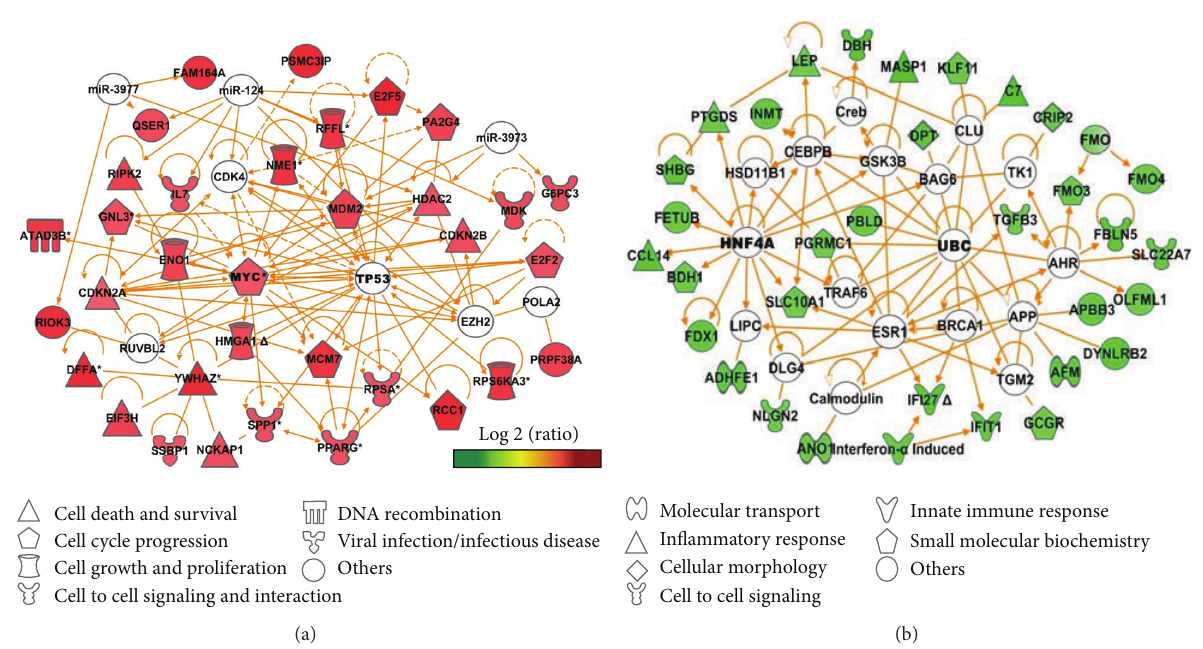
Figure 4: Network analysis of directly related genes which are upregulated and downregulated in HCC-R tumor tissues compared with HCC-NR tumor tissues. (a) The upregulated network includes genes dominated by regulators of cell cycle progression, cell growth and proliferation, DNA recombination, and cell-to-cell signaling genes. These are represented as respective shapes based on functional property in HCC-R tumor tissues. (b) The downregulated network includes genes reflecting the concurrent downregulation of genes related to innate immune response, cell-to-cell signaling, cell morphology, and cellular metabolism genes. These are represented as respective shapes based on their functional properties in HCC-R tumor tissues. The gray outlined nodules without expression are linker genes that are not altered in HCC-R but are statistically enriched for interaction with the altered